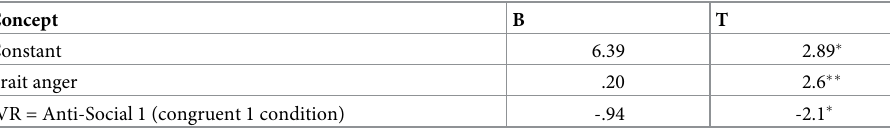
Table 3. Factors in the regression